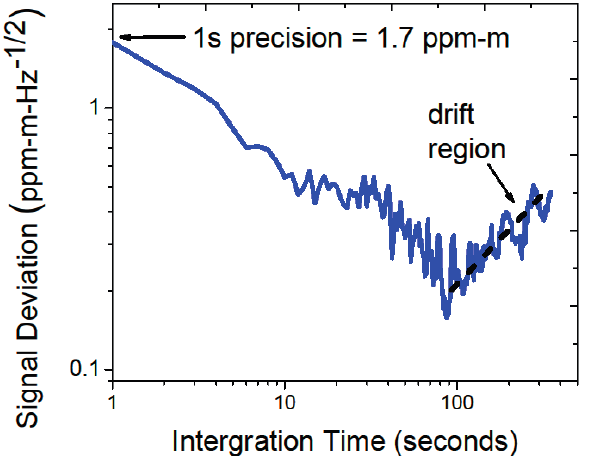
Figure 2. Allan Deviation analysis performed in the ambient methane conditions prior to transportation to Sallie’s Fen Environmental Station (SFES) shows a detection limit of 1.7 ppm-m-Hz − 1/2 and system drift dominated performance for averaging times >100